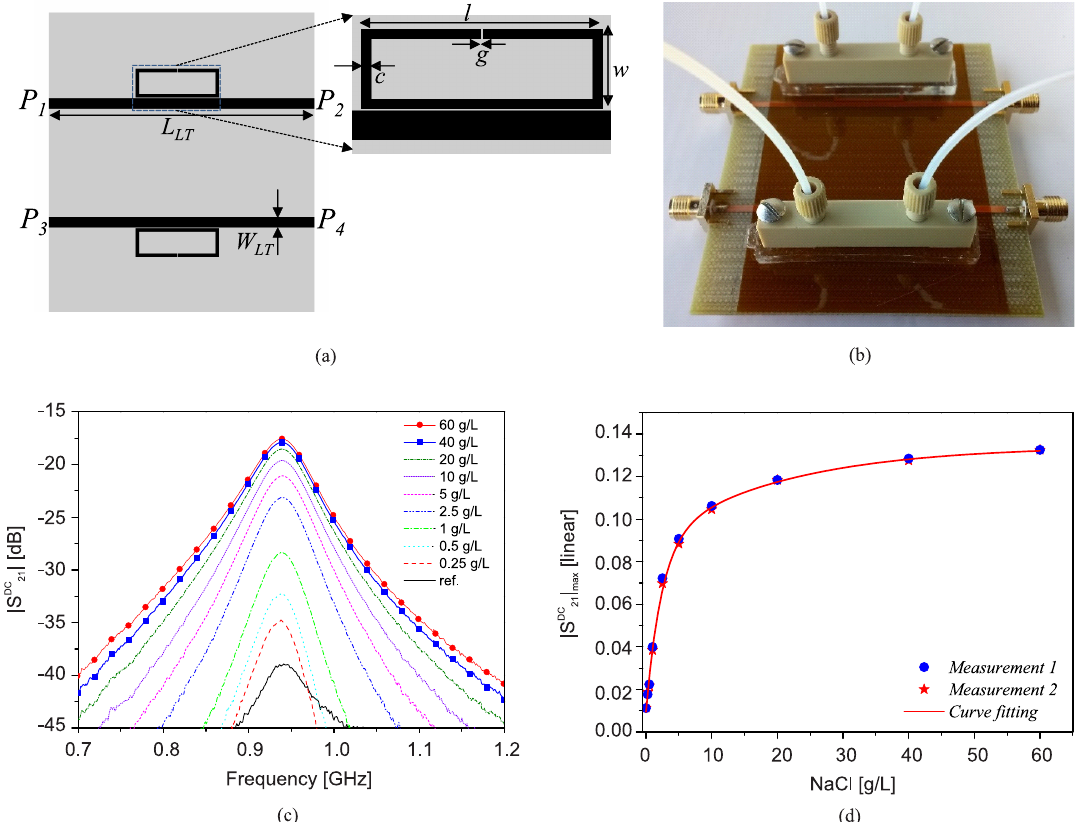
Figure 43. Topology of the differential sensor with the effects of NaCl concentration on the cross-mode transmission coefficient: ( a ) topology of the microwave structure of the SRR-based differential sensor; ( b ) photograph including the microwave structure, the fluidic channels (plus mechanical accessories) and connectors. Dimensions (in [ mm ] ) are: L LT = 76.5, W LT = 2.79, l = 24, c = 1, w = 8.17, g = 0.2. The ground plane is depicted in grey. The sensor was implemented in the FR4 substrate with the dielectric constant ε r = 4.4 and thickness h = 1.6 mm; ( c ) dependence of the cross-mode transmission coefficient on frequency; ( d ) relation between sodium concentration and ( d ), two measurement campaigns have been carried out in order to ensure repeatability. Reprinted with permission from Ref.